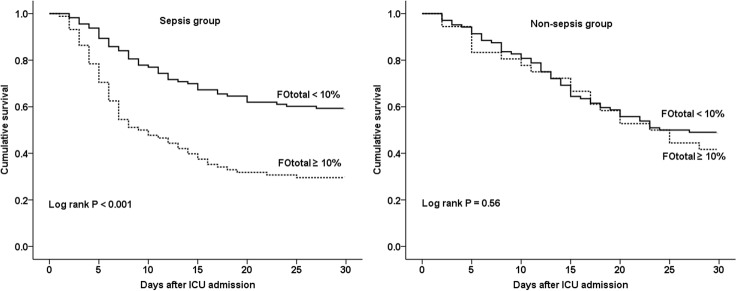
Kaplan-Meier survival estimate by %FOtotal ≥ 10% or < 10% in the sepsis group (n = 201) and the non-sepsis group (n = 140).In the sepsis group, there was a significant difference in survival among patients with %FOtotal ≥ 10% or < 10% (P < 0.001). However, in the non-sepsis group, there was no difference in survival (P = 0.56). %FOtotal = percentage of total fluid overload from baseline body weight from 3 days before CRRT initiation to ICU discharge. ICU = intensive care unit.